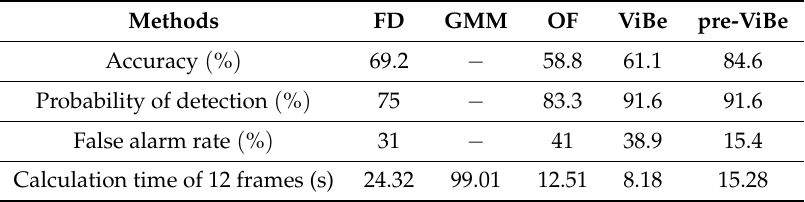
Figure 11. ( a – f ) are the original image, FD, GMM, OF, ViBe, pre-ViBe results. Take one of the best frames for comparison. In the figure, the red boxes mark the manually marked targets (groundtruth), the green boxes mark the successfully detected targets, and the yellow boxes mark the false detection targets. Table 1. Performance of each